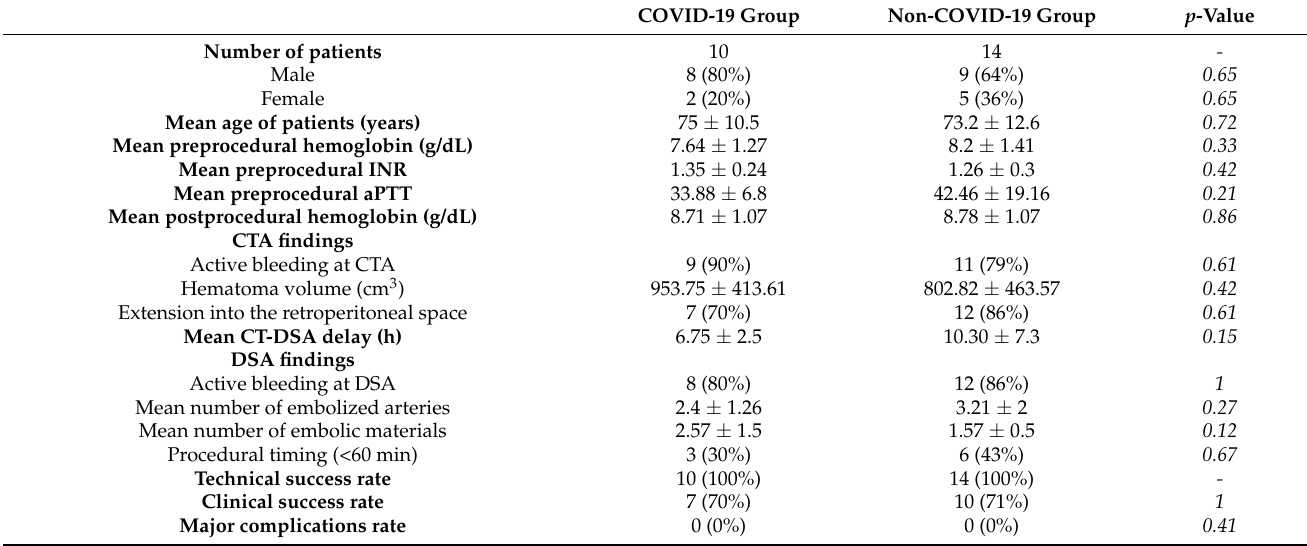
Table 3. Comparative results between COVID-19 and non-COVID-19 groups. COVID-19 Group Non-COVID-19 Group p -Value Number of